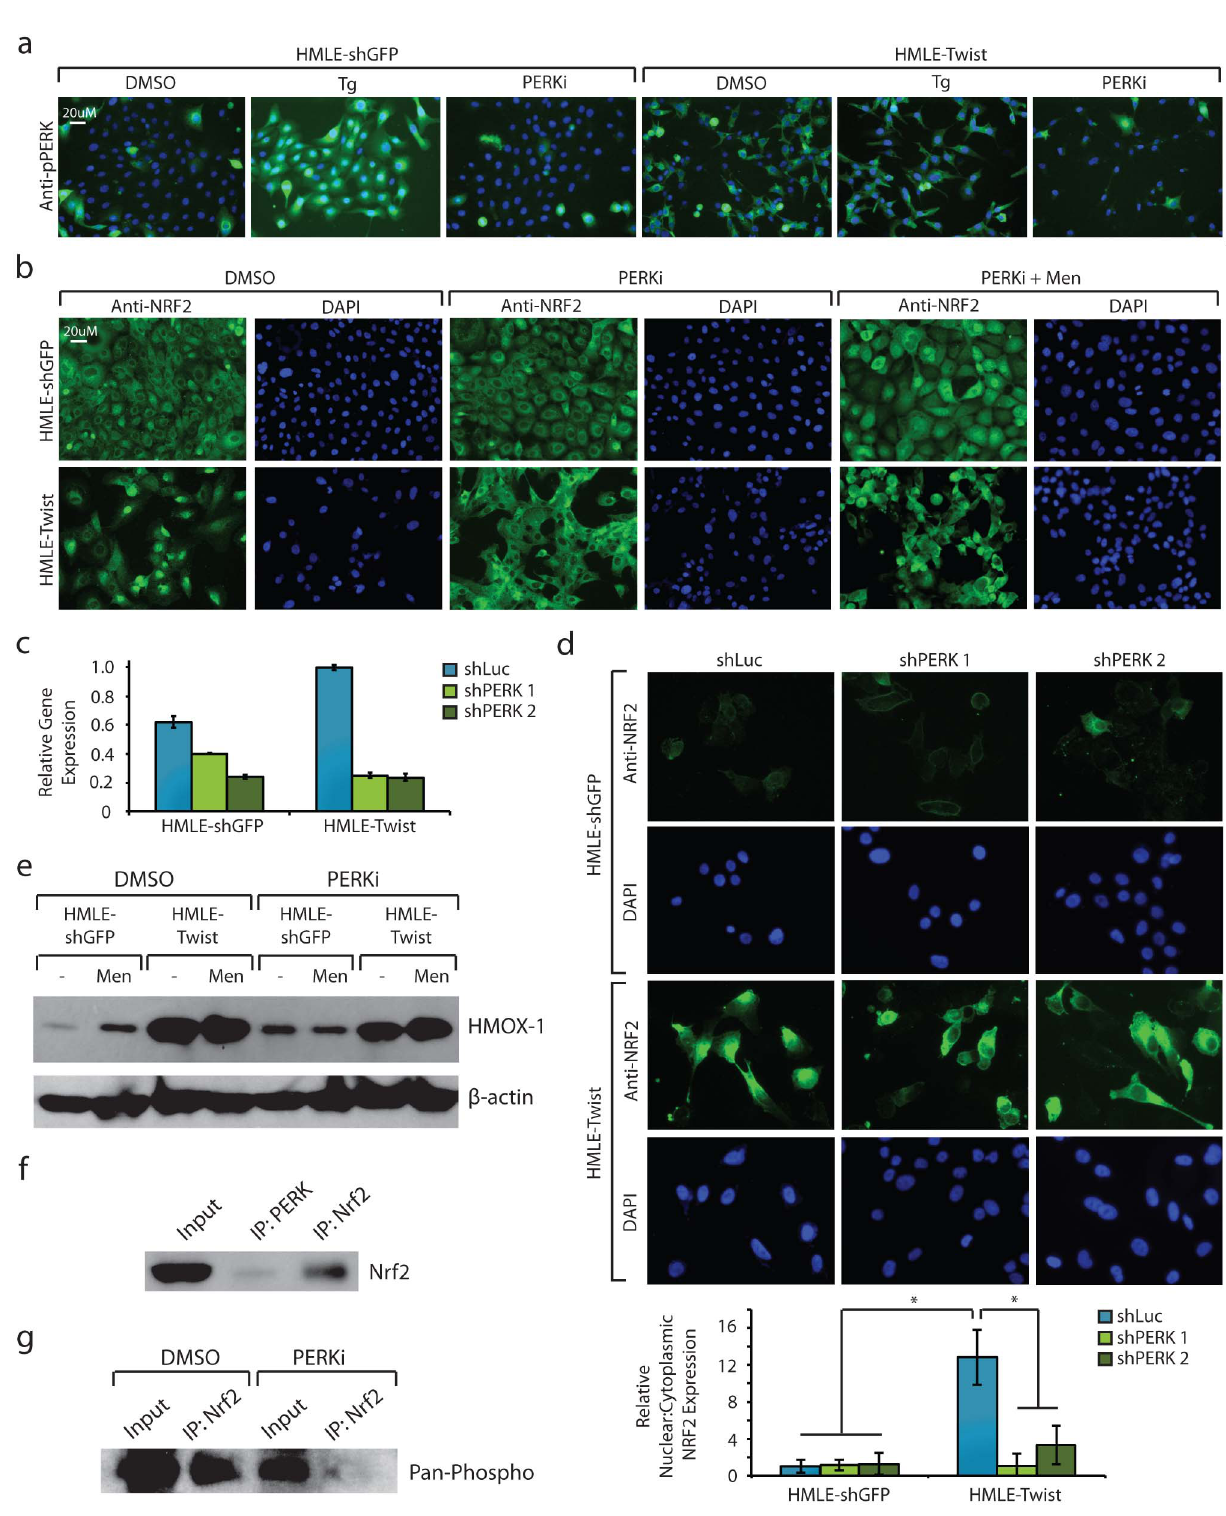
Figure 2. Nrf2 is constitutively activated by PERK in de-differentiated cells. (a) Immunofluorescence microscopy images of phospho-PERK (pPERK) upon treatment with 40 nM thapsigargin (Tg) for 2 h or 1 m M PERK inhibitor (PERKi) for 2 d. pPERK protein was indirectly labeled with a secondary Alexa Fluor 488 antibody (green channel) and cell nuclei labeled with DAPI (blue channel). (b) Immunofluorescence microscopy images of Nrf2 localization upon treatment with 1 m M PERKi or DMSO for 2 d, followed by 40 m M menadione or DMSO for 2 h. Nrf2 protein was indirectly labeled with a secondary Alexa Fluor 488 antibody (green channel) and cell nuclei labeled with DAPI (blue channel). (c) Quantitative RT-PCR analysis of PERK gene expression in cells stably expressing control (shLuc) or PERK-specific shRNA (shPERK 1 and shPERK 2). Expression is shown normalized to the HMLE-Twist shLuc sample. (d) Immunofluorescence microscopy images of Nrf2 localization in cell lines with stable knockdown of PERK compared